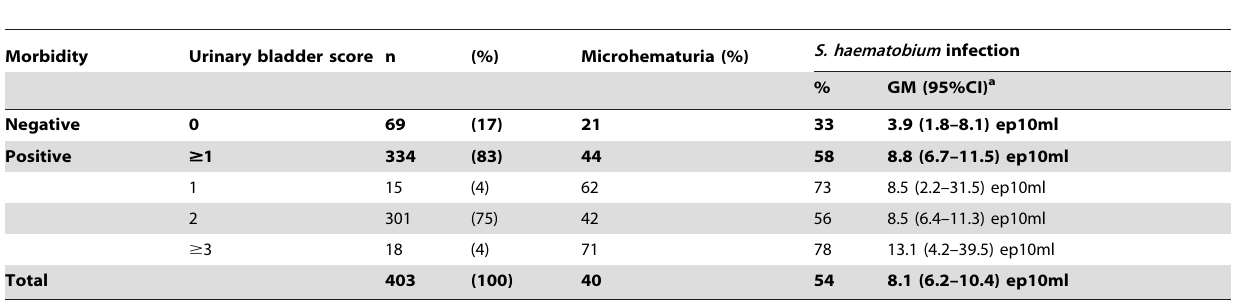
Table 1. Schistosoma haematobium -associated bladder morbidity, hematuria and S. haematobium infection in the two co-endemic communities studied.